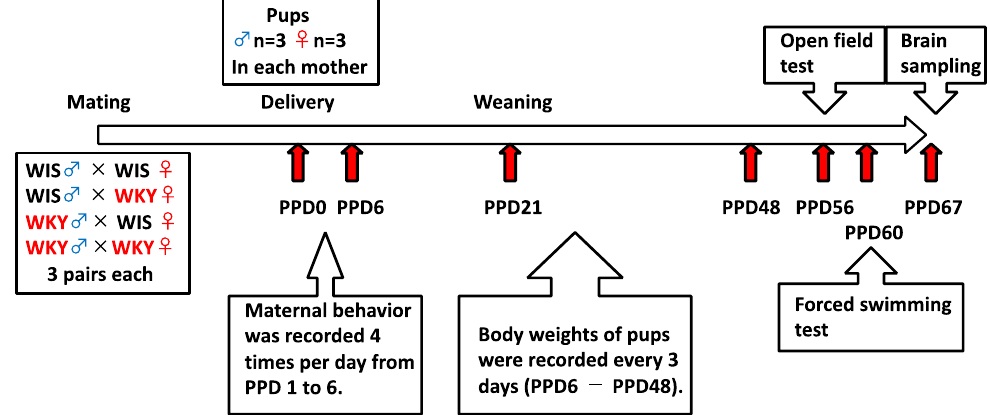
Figure 4. Experimental design of this study.